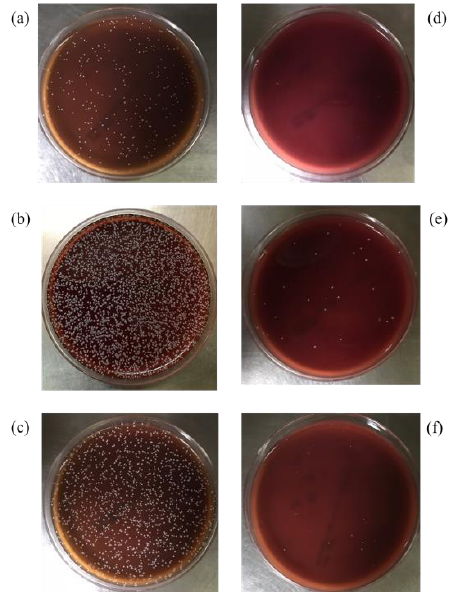
Figure 9. The images of H. pylori adhesion effect and antibacterial effects. ( a , d ) Two-dimensional IR/EOEOEA model. ( b , e ) Three-dimensional IR/EOEOEA model. ( c , f ) ABS model. ( a – c ) Adhesion effect of H. pylori without tetracycline treatment. ( d – f ) The antibacterial effects of H. pylori with tetracycline treatment for 24 h.